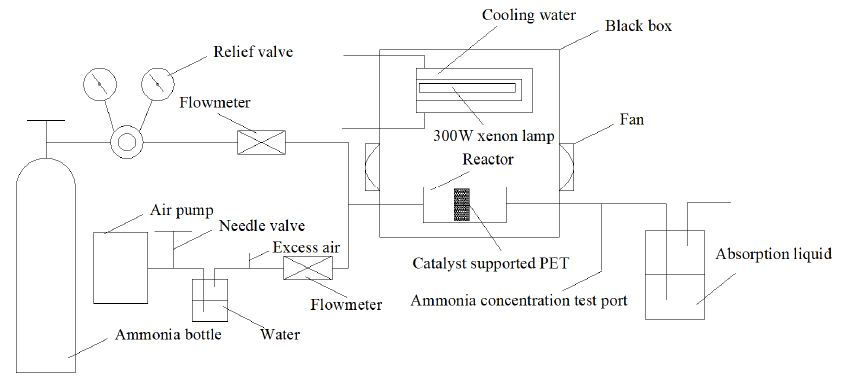
Figure 13. Device diagram of the photocatalytic degradation of gaseous ammonia.